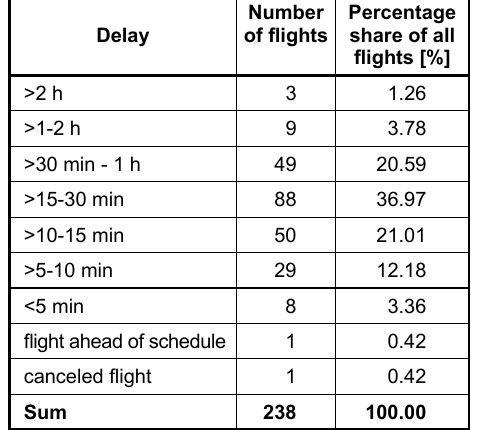
Table 2. Delays on Monday 25.03.2019